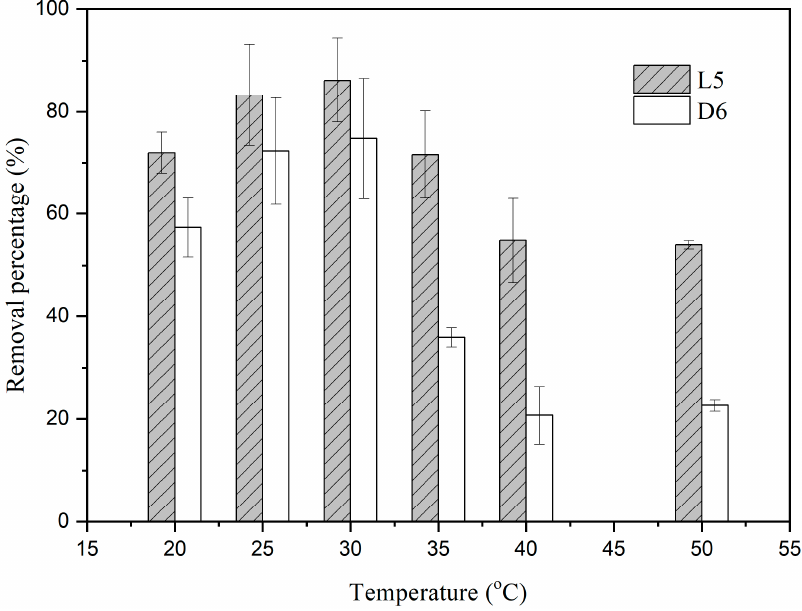
Figure 6. Effect of temperature on the adsorption of L5 and D6 on MSW.